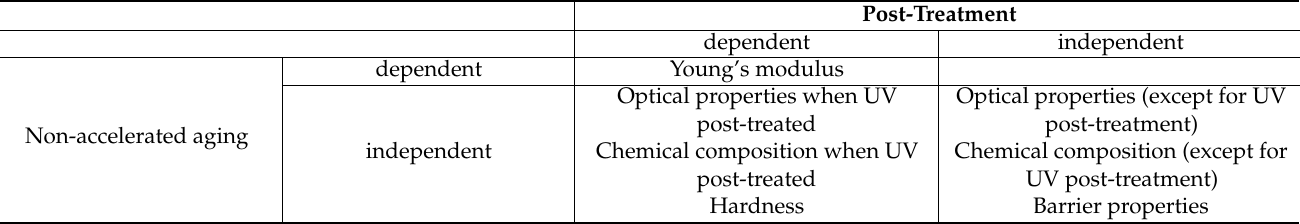
Non-accelerated aging